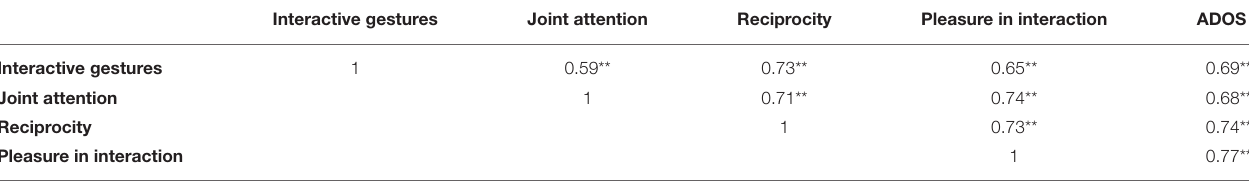
TABLE 4 | Pearson’s correlation values between the first evaluation results and the total of the second evaluation.